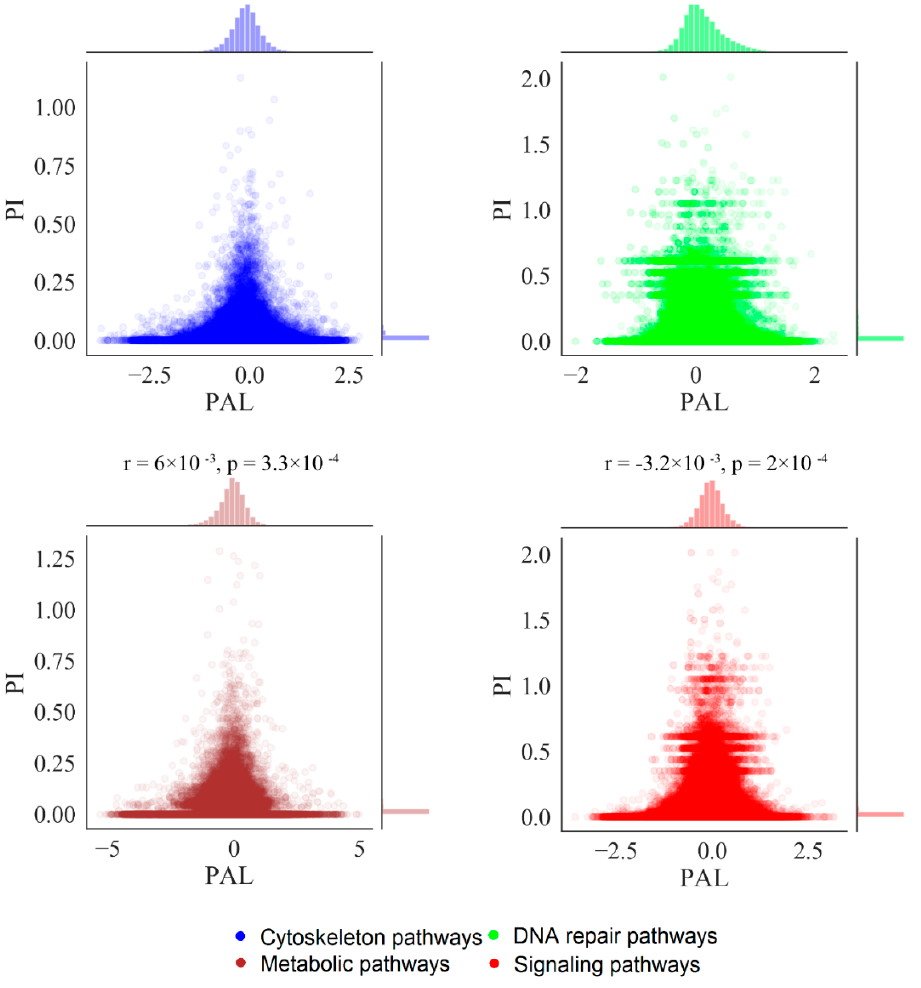
Figure 10. Correlation of PI and PAL scores for different types of molecular pathways in 4910 tumor samples.